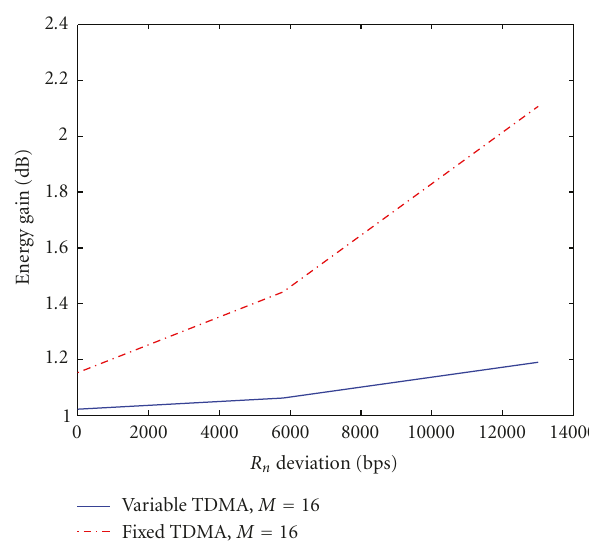
Figure 3: Energy gain with respect to fixed TDMA and variable length TDMA with 16-QAM modulation, N = 896 symbol